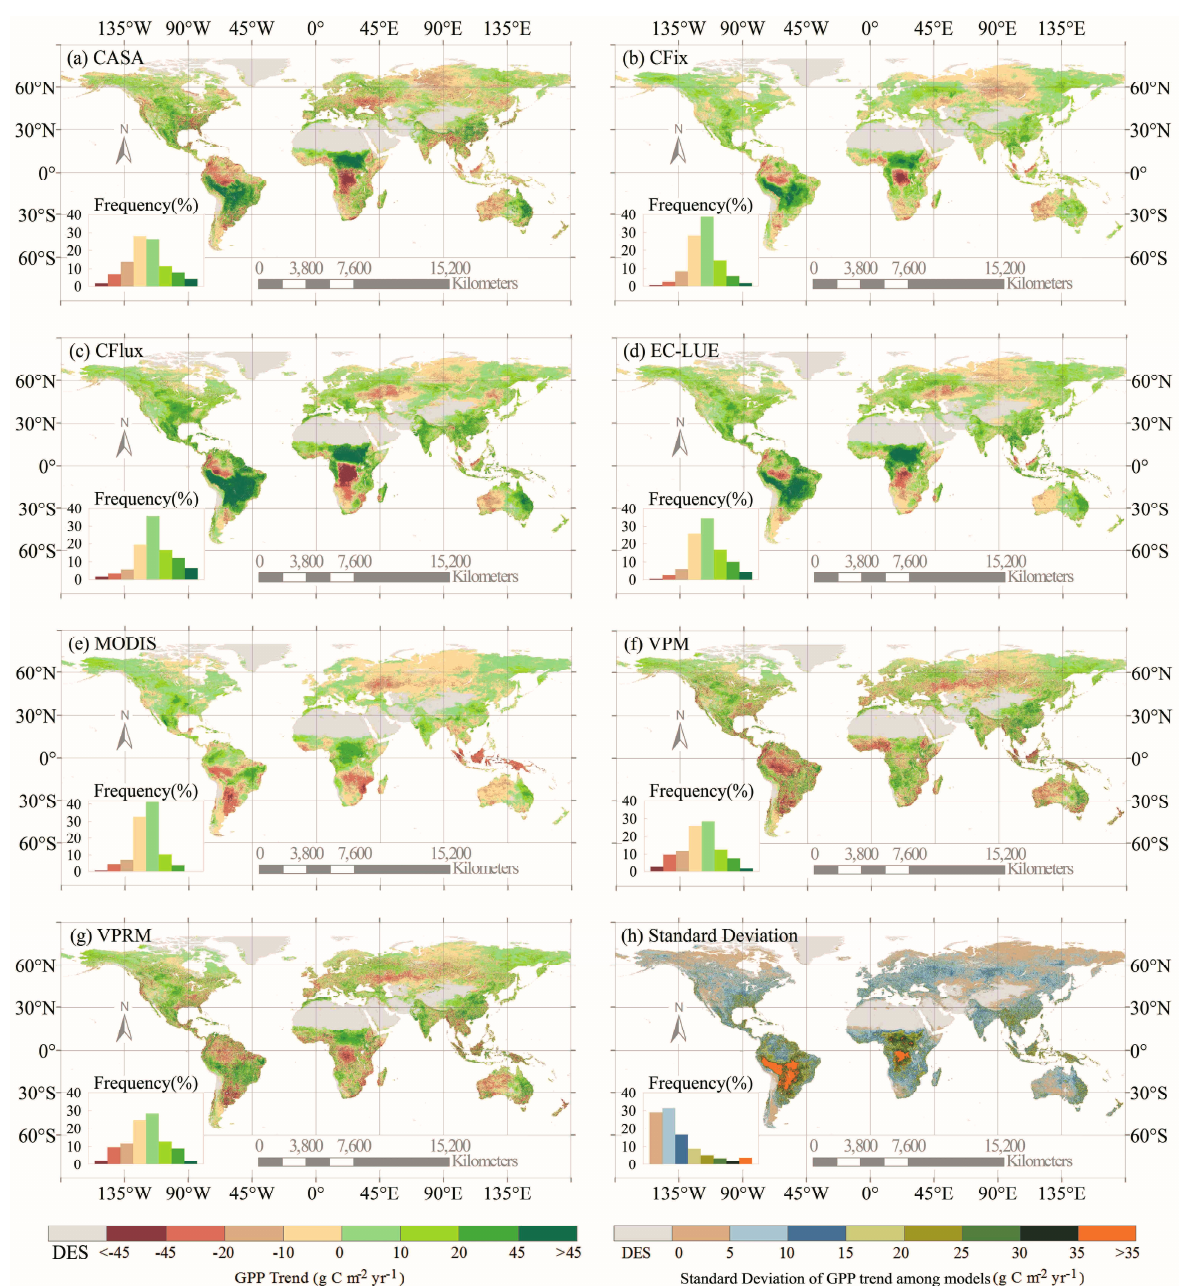
Figure 2. Spatial patterns of global GPP trend from 2000 to 2010 estimated by ( a ) CASA; ( b ) CFix; ( c ) CFlux; ( d ) EC-LUE; ( e ) MODIS; ( f ) VPM; and ( g ) VPRM models; ( h ) the number of models with increased GPP. DES is no vegetation